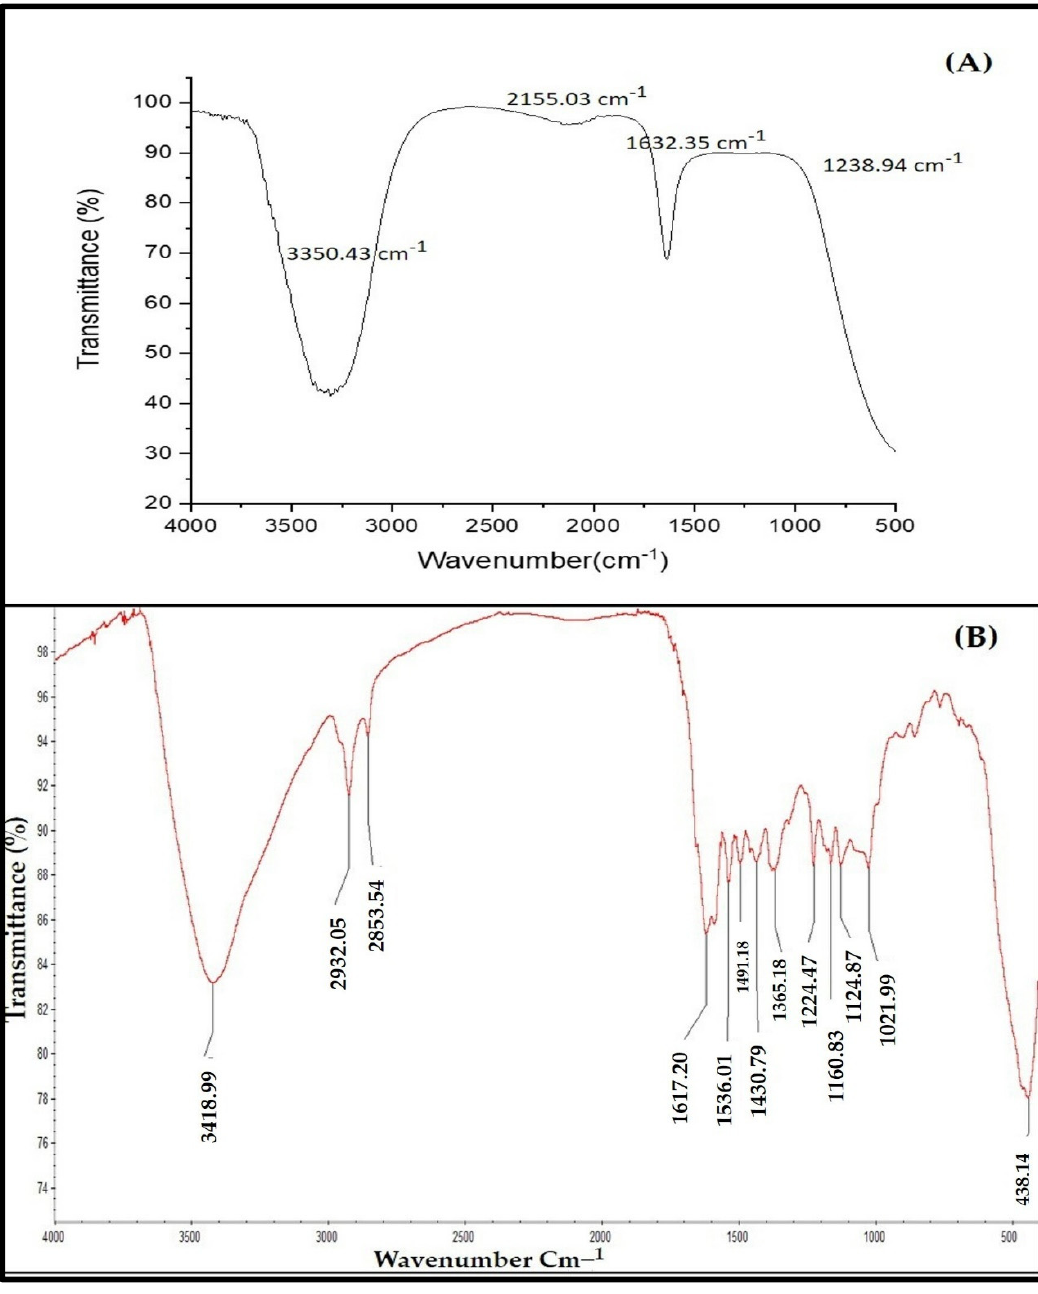
Figure 5. FTIR Spectrum of ( A ) Raphanus sativus leaf extract ( B ) ZnONPs.